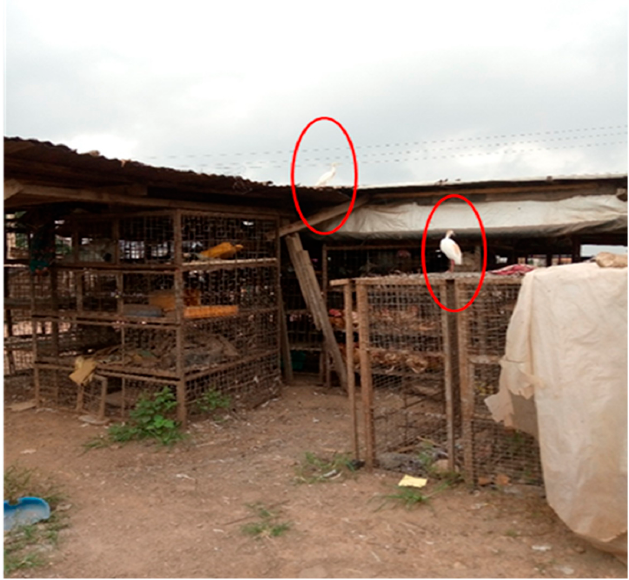
Figure 2. Migratory wild chickens were observed to be perching on cages close to the caged live chickens. Table 1. Sociodemographic profiles of respondents (LBS) from the eight LBMs investigated in Abeokuta, Ogun